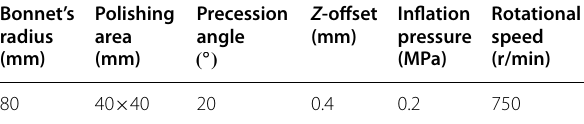
Table 1 Area polishing parameters